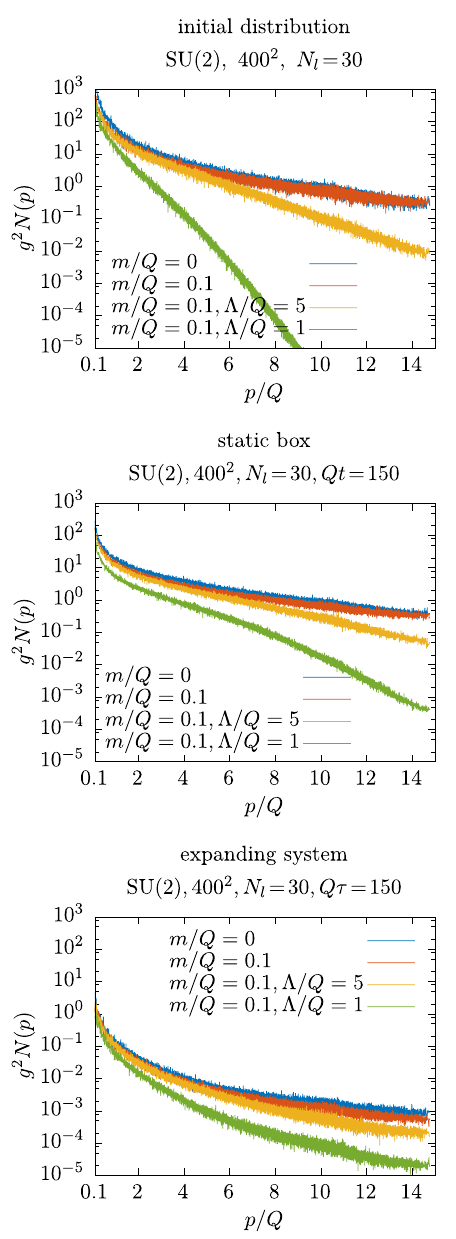
Fig. 7 Occupation number as a function of the momentum p / Q at initial time (top) and after the same number of time steps in the static box (middle) and in the expanding formulation (bottom). The highest momentumisdefinedbythelatticecutoff, p max =